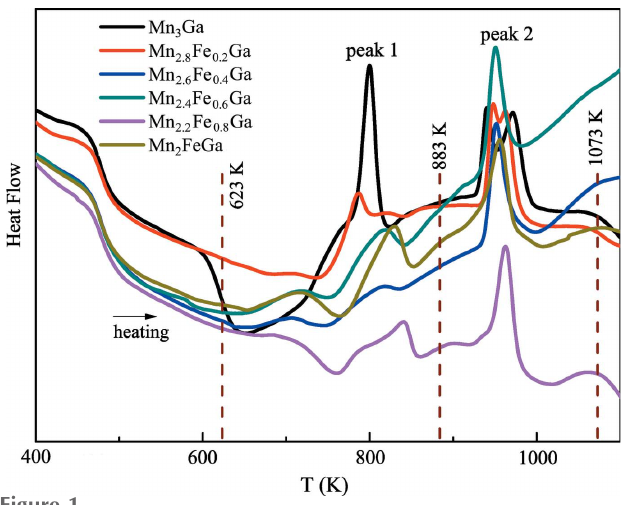
Figure 1 DSC measurements of the as-cast ingot samples of Mn 3 (cid:2) x Fe x Ga ( x = 0, 0.2, 0.4, 0.6, 0.8, 1) during the heating